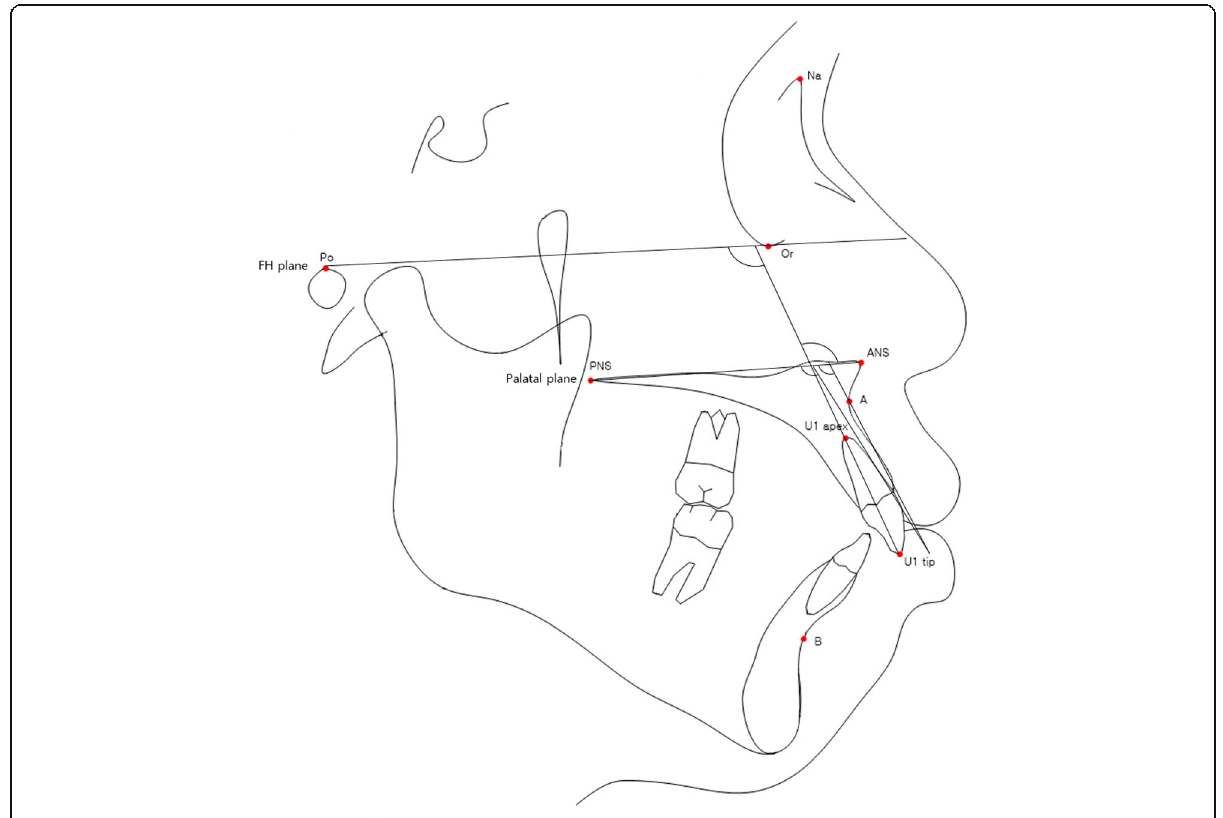
Fig. 4 Angular variables used to determine the extent of intrusion and retraction of the incisor